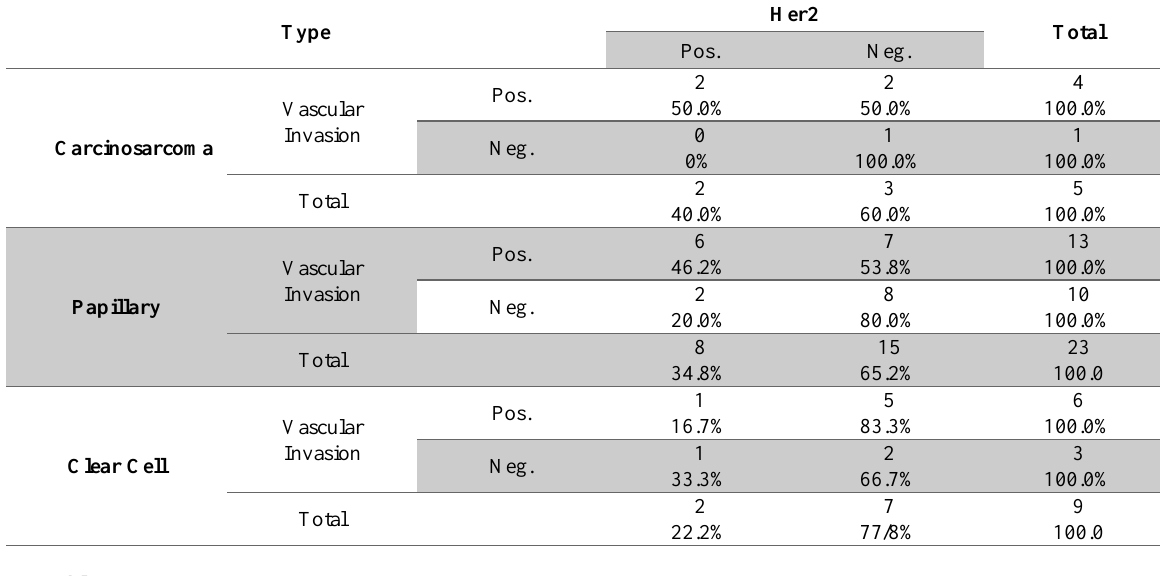
Table 4. Her2/neu overexpression and vascular invasion